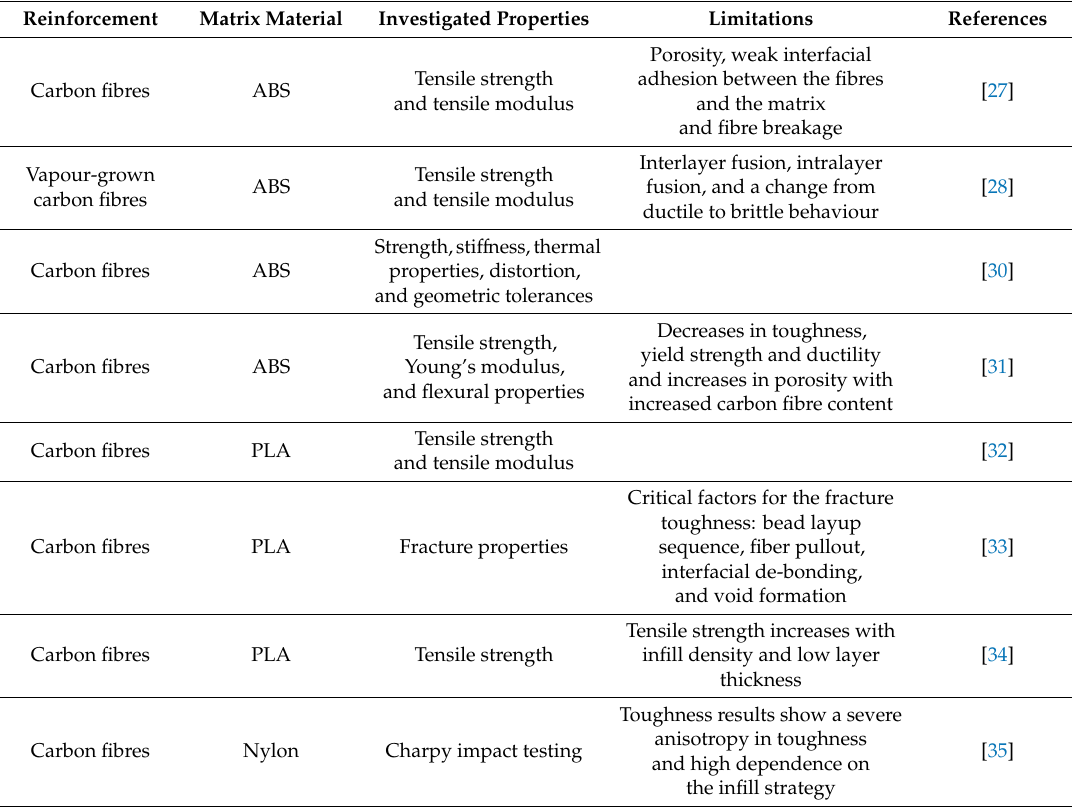
Table 1. A summary of some studies on FFF with chopped